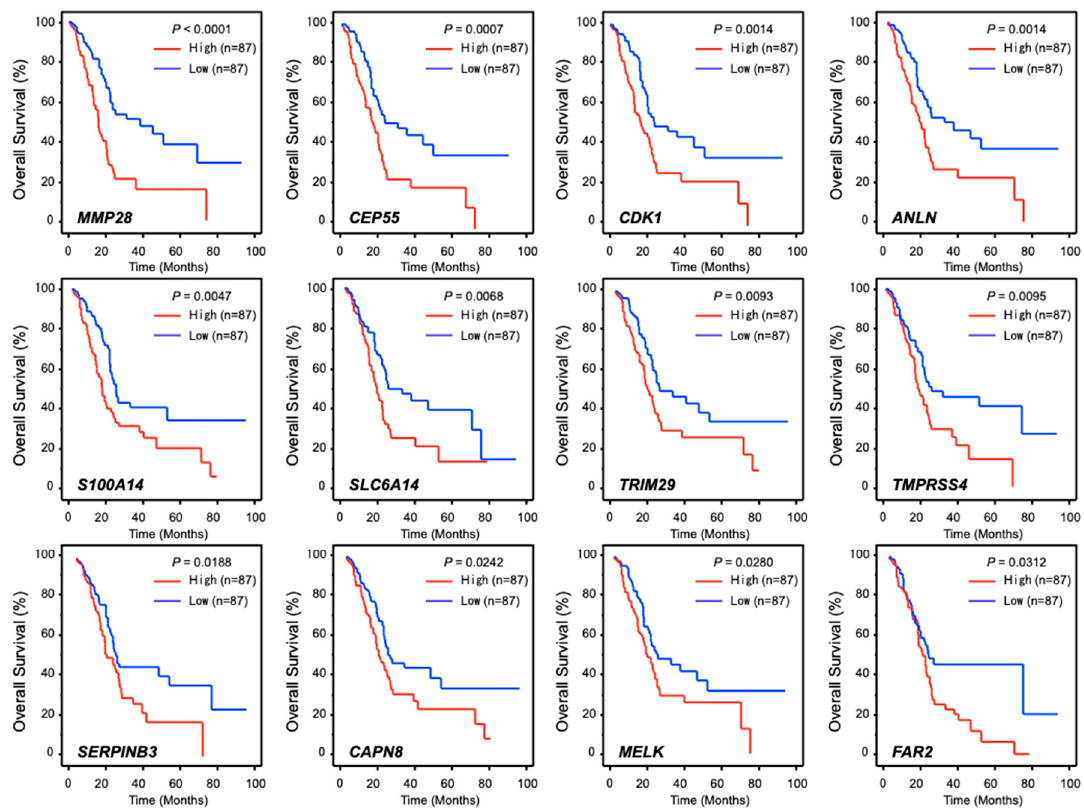
Figure 6. Clinical significance of RACGAP1 downstream genes associated with a poor prognosis of patients with PDAC.